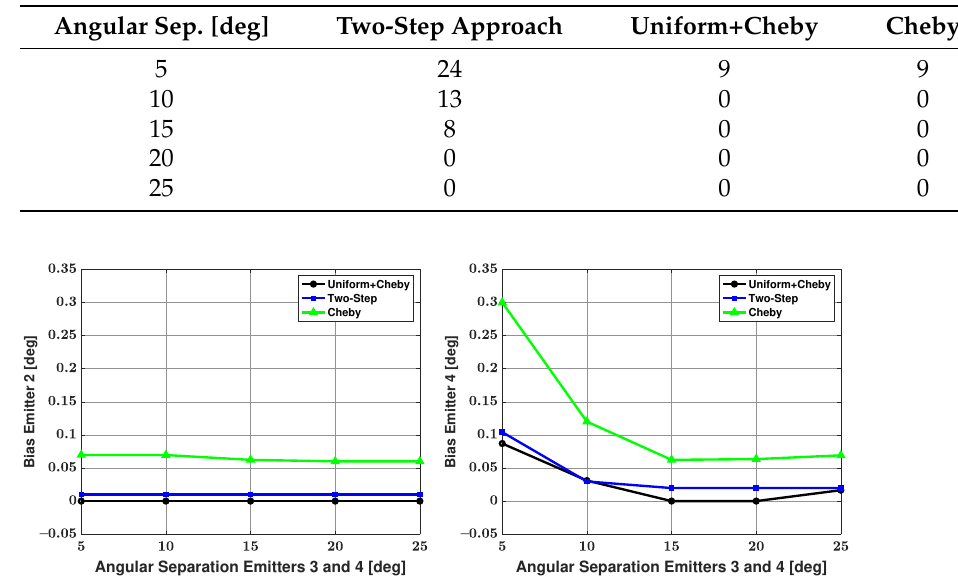
Figure 10. Bias in the estimated direction versus angular separation between emitters #3 and #4: emitter #2 ( left ) and emitter #4 ( right ); the three proposed methods are used for estimation; SNR of emitter #1 = 18 dB, emitter #2 = 5 dB, emitter #3 = 25 dB, and emitter #4 = 0 dB, respectively; 100 snapshots; and 500 trials.